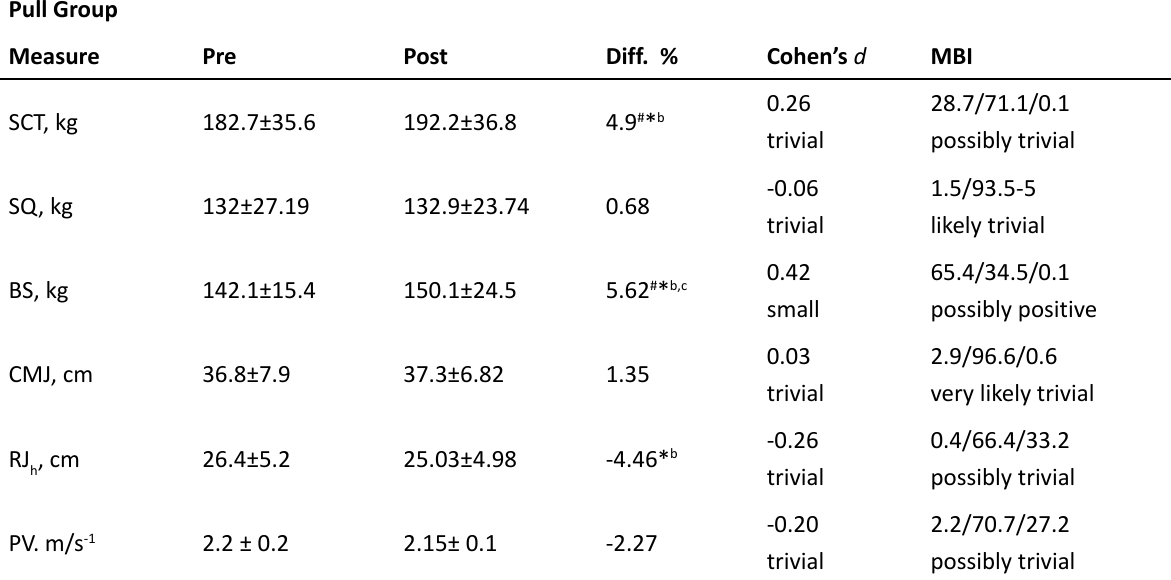
Table 3. Pretesting and Posttesting Results of Pull Group